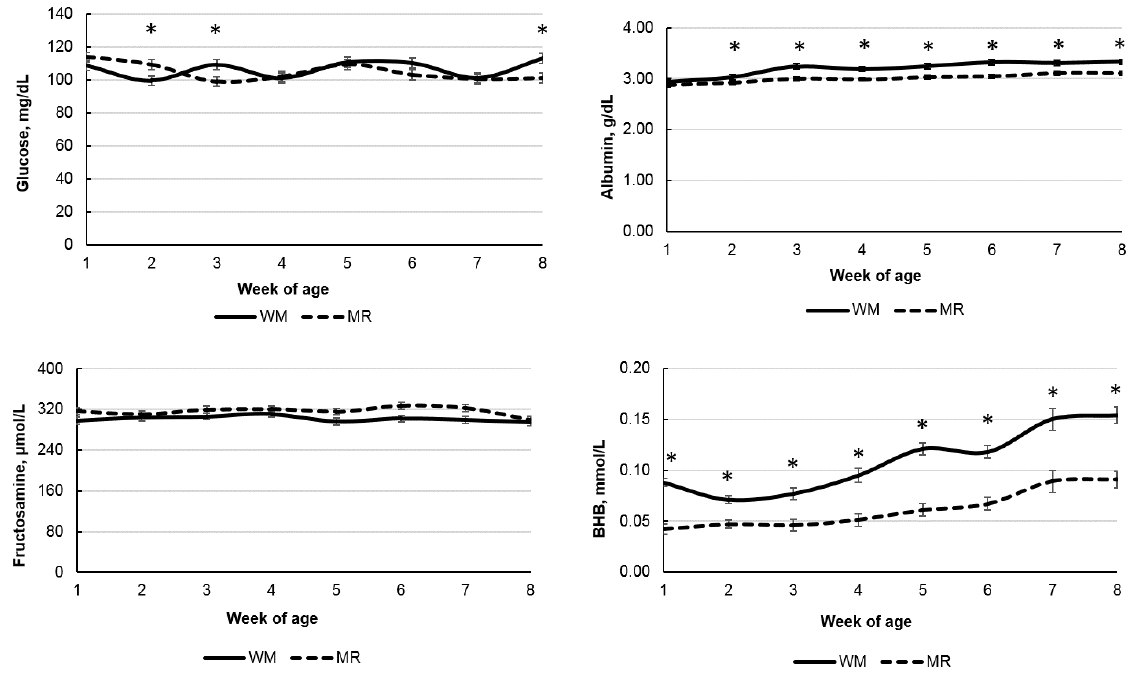
Figure 3. Blood metabolites according to the age of calves fed whole milk (WM) or milk replacer (MR) as liquid diet. * Denotes difference between liquid diets with p < 0.05.